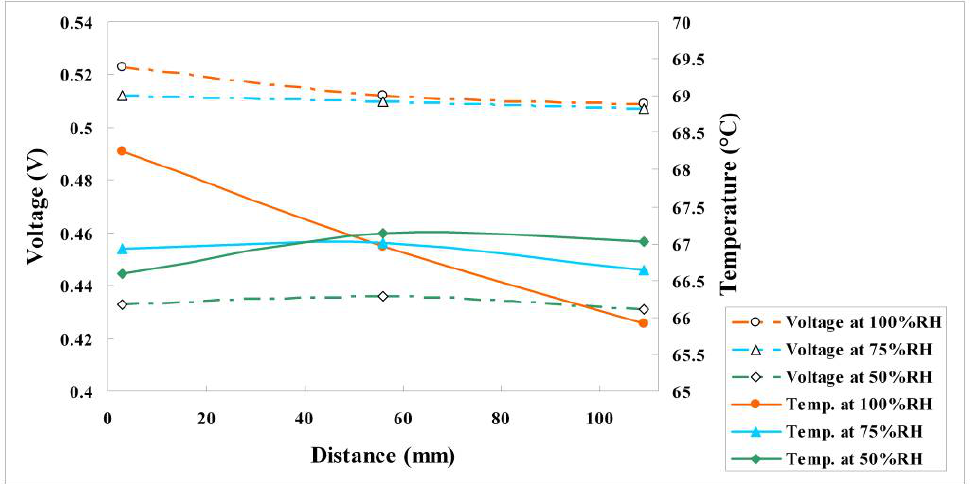
Figure 18. Variation of voltage and temperature at upstream, midstream and downstream (1 A/cm 2